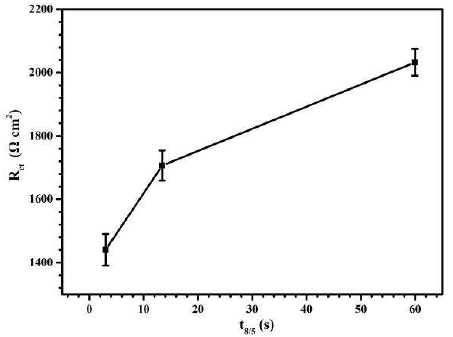
Figure 18. Fitting results of R ct for the ICCGHAZs with different cooling rate in 3.5 wt% NaCl solu- tion.